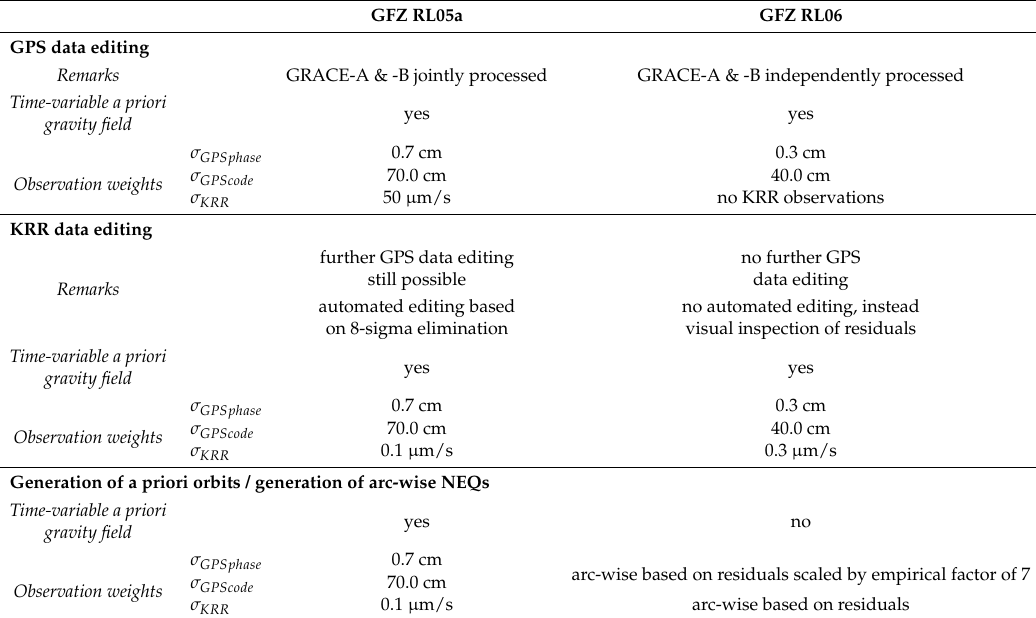
Table 2. Overview of GFZ RL05a and RL06 processing